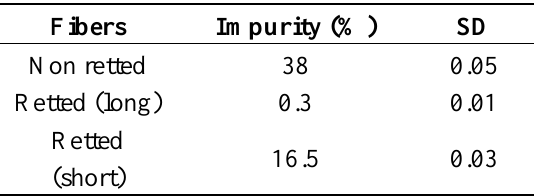
Table 1. Percentage Impurities in